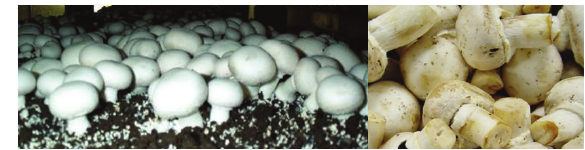
Figure 1: Agaricus species, the most cultivated mushroom world- wide.